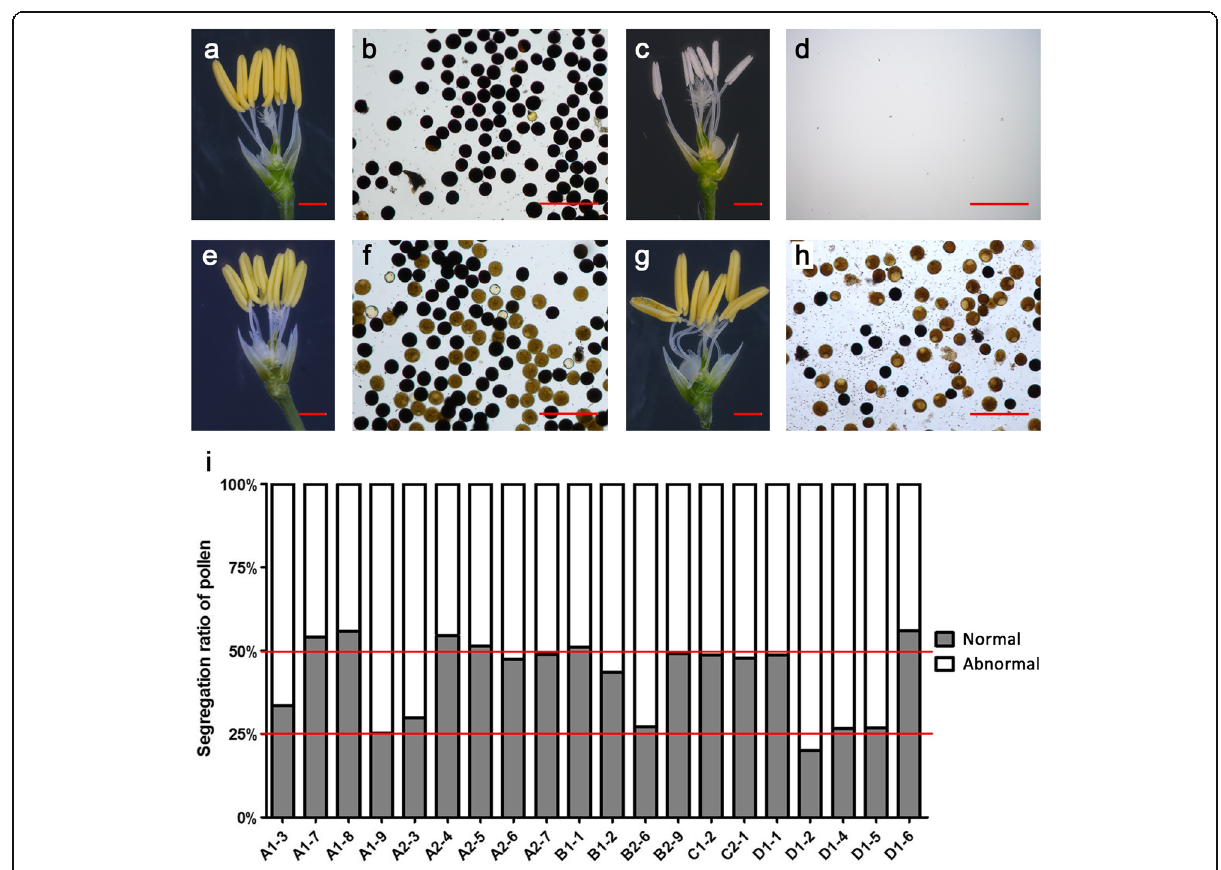
Fig. 2 Anther morphology and pollen grains of the T 0 transgenic plants. ( a-h ) Anthers and pollen grains from wild type ( a, b ), osnp1 mutant ( c, d ), and representative transgenic plants A2-6 ( e, f ) and B2-6 ( g, h ). ( i ) The ratios of normal pollen grains to abnormal pollen grains from different transgenic plants. Pollen grains were stained with 1% I2-KI solution. Bar: ( a, c, d, g ) = 2 mm; ( b, d, f, h ) = 200 μ